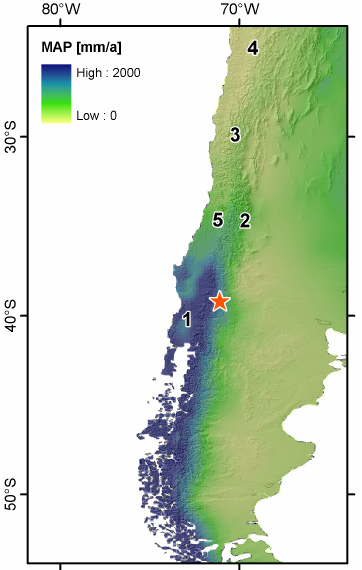
Fig. 1. Location of the research area, the Rucachoroi Valley (star), and other sites discussed in the text. 1 – Chilean Lake District, 2 – Mendoza Andes, 3 – Cordon de Dona Rosa, 4 – Atacama Desert, 5 – Laguna Tagua Tagua. MAP=mean annual